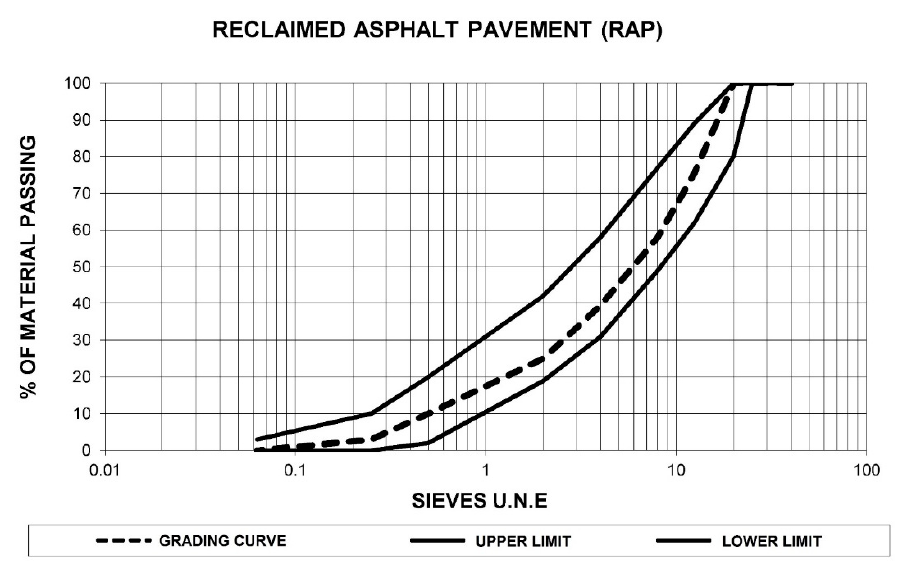
Figure 3. RAP grading curve.